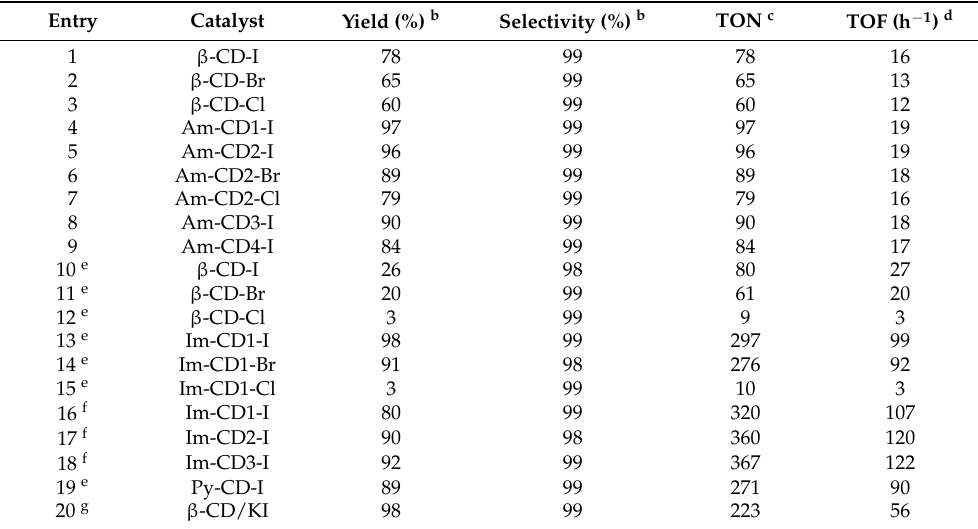
Table 1. Results of coupling reaction of CO 2 and PO catalyzed by various catalysts a .